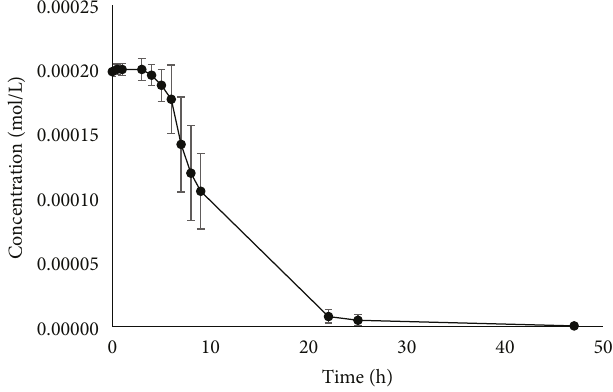
Figure 13: Kinetics degradation of ketorolac with ultraviolet radiation.